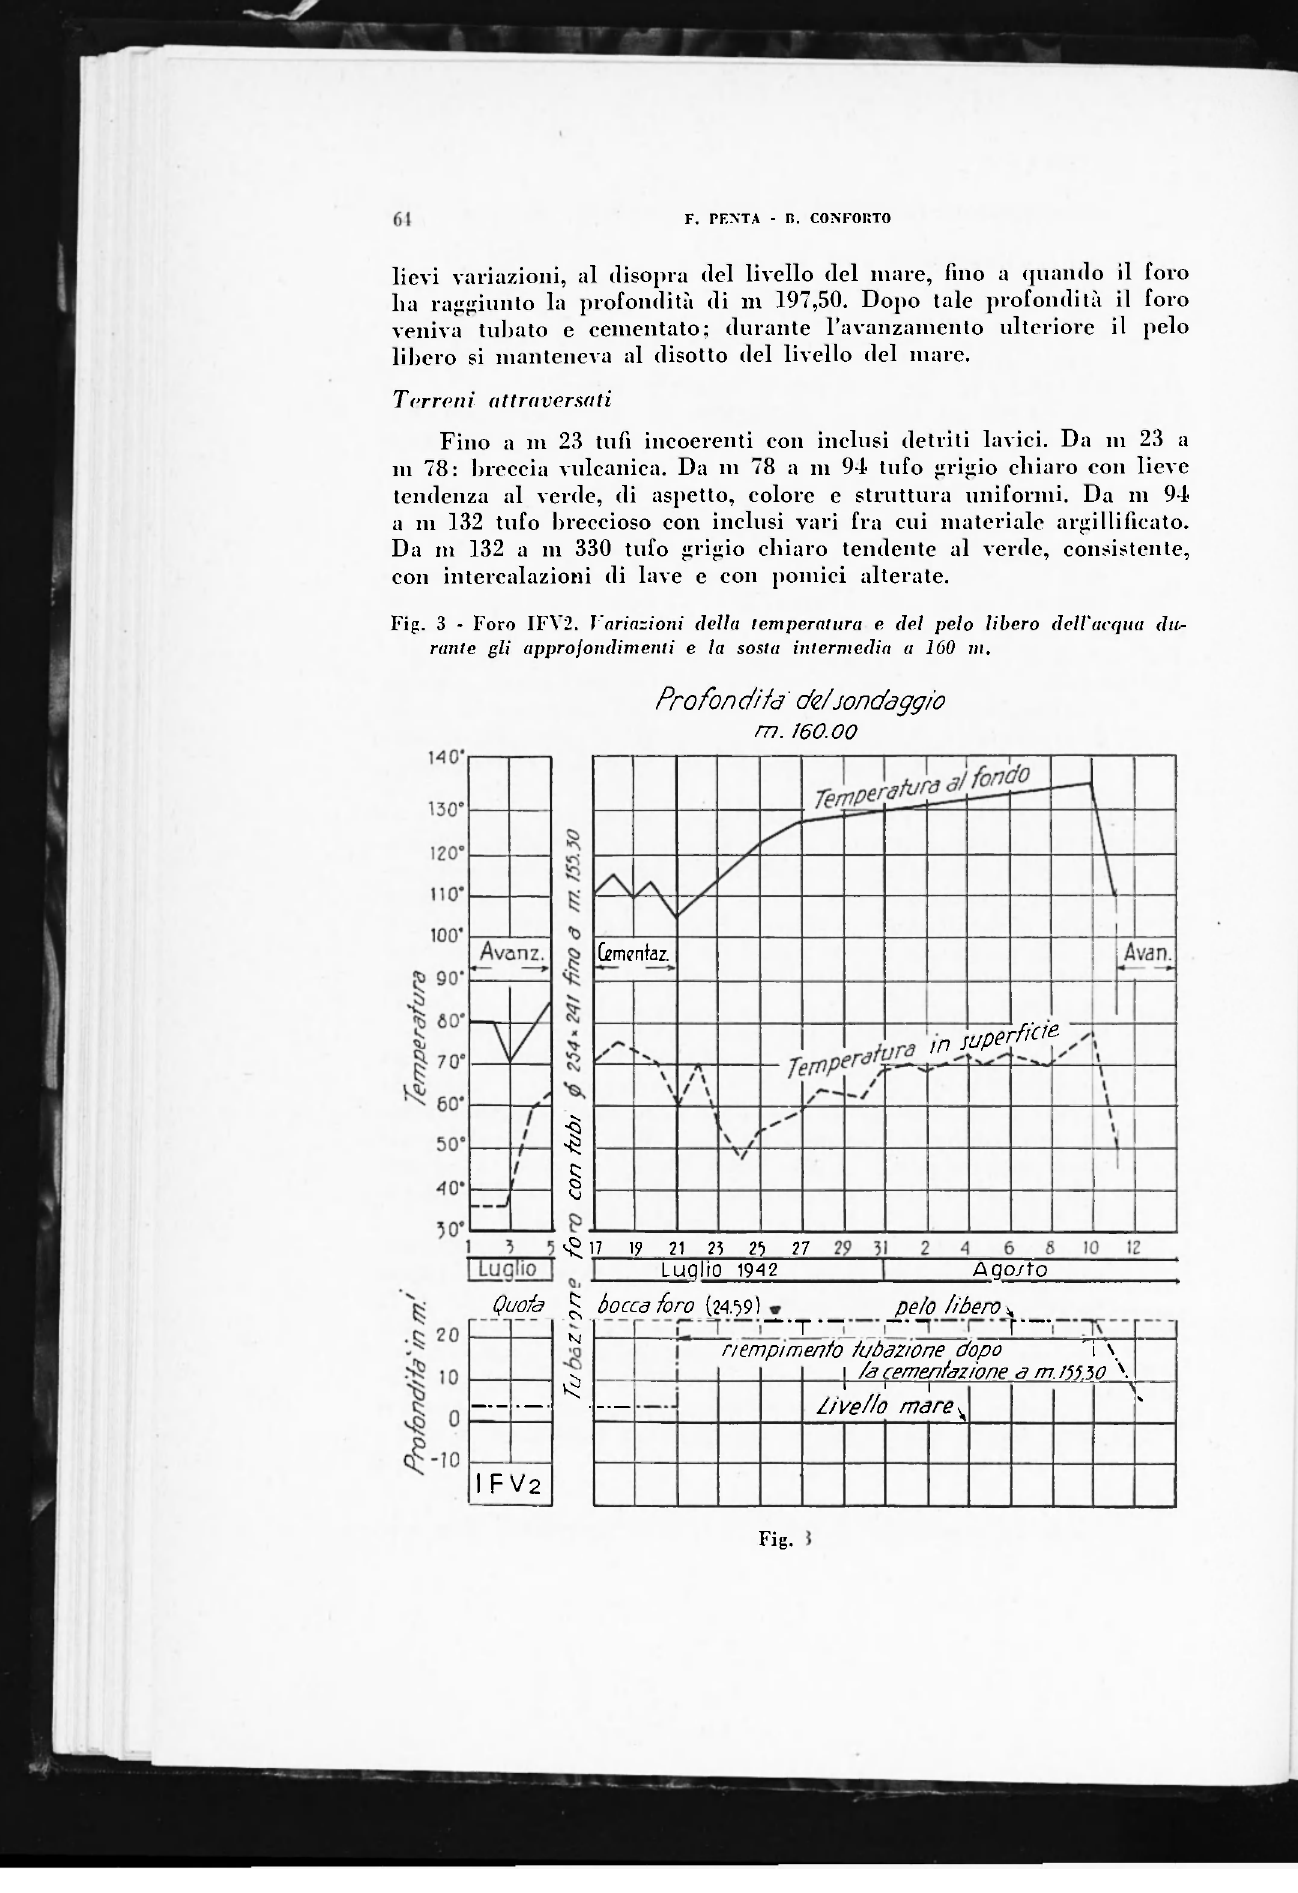
Fig. 3 - Foro IFY2. Variazioni della